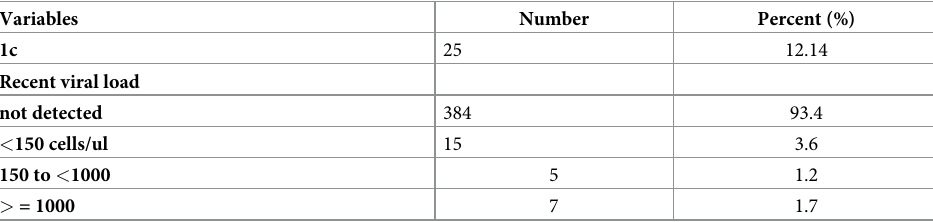
PLOS ONE | https://doi.org/10.1371/journal.pone.0259944 January 12,